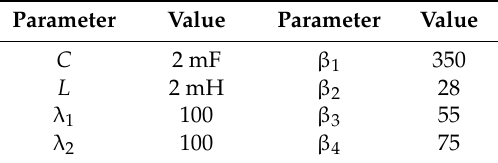
Table 1. Values of the